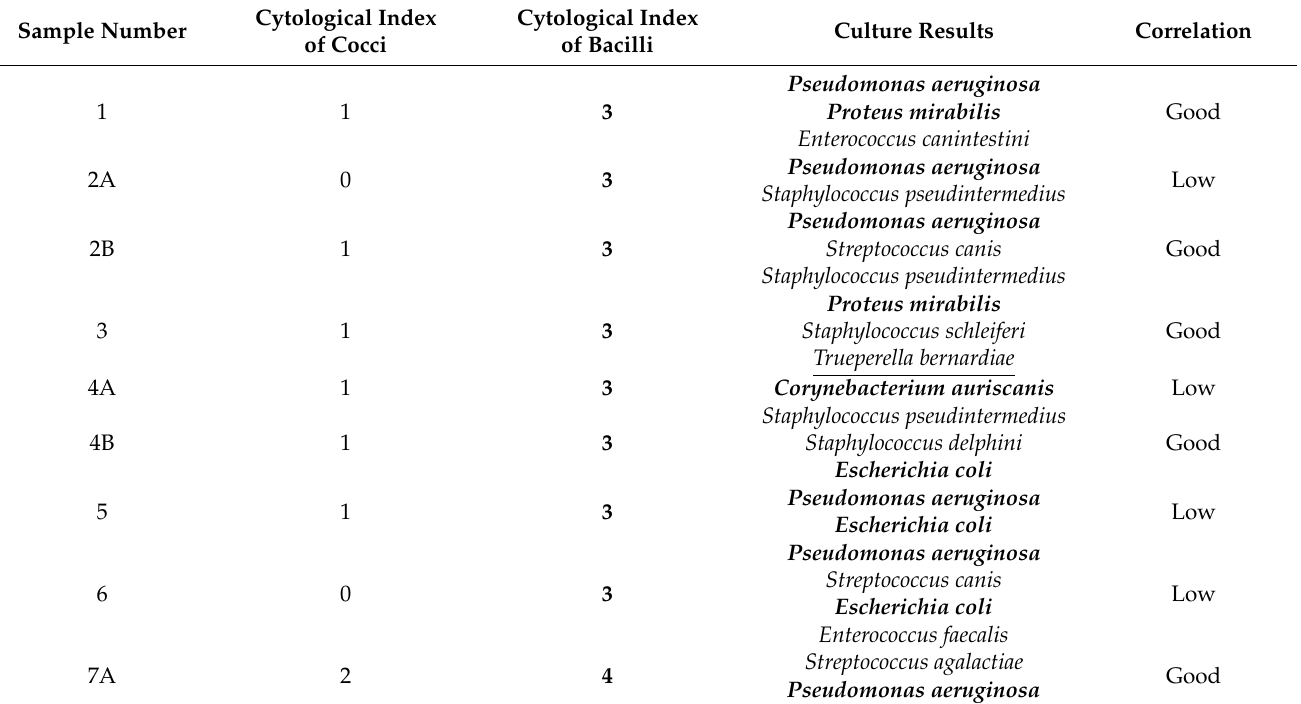
Table 2. Comparison of cytology and bacterial culture (with estimated correlation). Bacteria in non-bolded type have a morphology of cocci and in bold type a morphology of bacilli. Trueperella bernardiae (underlined) is a Gram-positive bacterium with a morphology varying from bacillus to coccoid